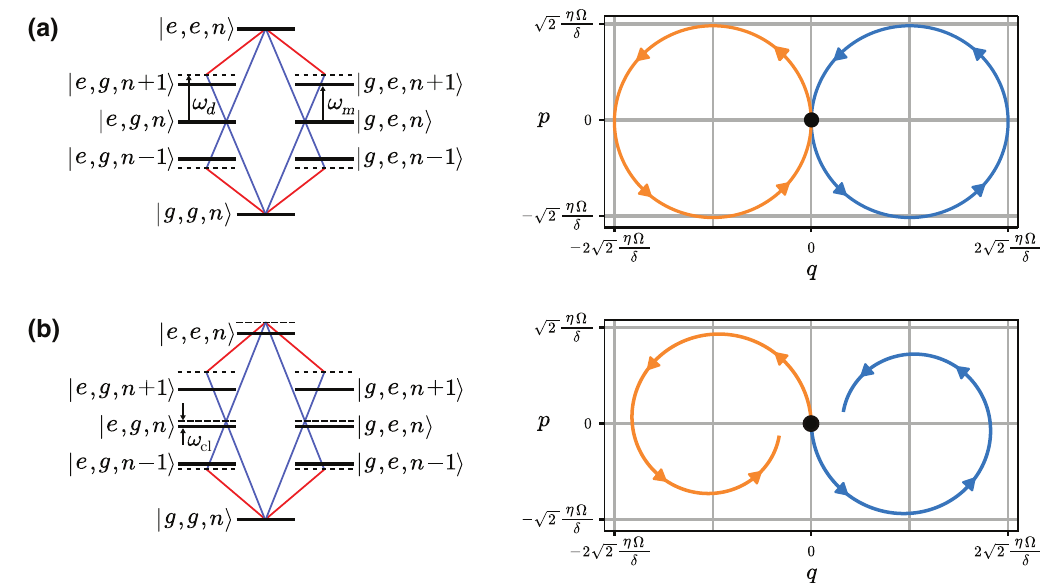
FIG. 1. (a) Left: energy level diagram for two ions with quantized center-of-mass vibrational mode of frequency ω m interacting with a bichromatic laser of frequencies ω 1 = ω eg + ω d and ω 2 = ω eg − ω d . The laser allows a resonant two-photon transition between | g , g , n (cid:3) and | e , e , n (cid:3) . There are four different paths, each of them going through an intermediate virtual state separated by δ = ω − ω m d from the first motional sidebands ( | g , e , n ± 1 (cid:3) , | e , g , n ± 1 (cid:3) ). A similar diagram can be drawn for the two-photon transition between the states | e , g , n (cid:3) and | g , e , n (cid:3) . Right: trajectory in phase space induced by the gate with constant Rabi frequency with the ions in the − 1 eigenstate (in blue), with the black circle indicating the initial motional state. If we apply the + 1 eigenstate of S ϕ (in orange) and the gate for the correct amount of time, the trajectory returns to the initial point in phase space. The rotation introduced by the gate is given by the area enclosed by the trajectory. (b) Left: a source of error in the MS gate is when the frequencies of the laser are not centered around the carrier, but instead have a center line detuning ω cl = ω eg − (ω 1 + ω 2 )/ 2, which we consider to be time independent. The larger the frequency ω cl is, the less resonant the two-photon process is, which decreases the fidelity of the gate. Right: similar phase space plot as in the previous case but with ω cl (cid:5)= 0. The trajectories for this case are dependent on the initial motional state, where for this figure, we have considered it to be | n = 0 (cid:3)